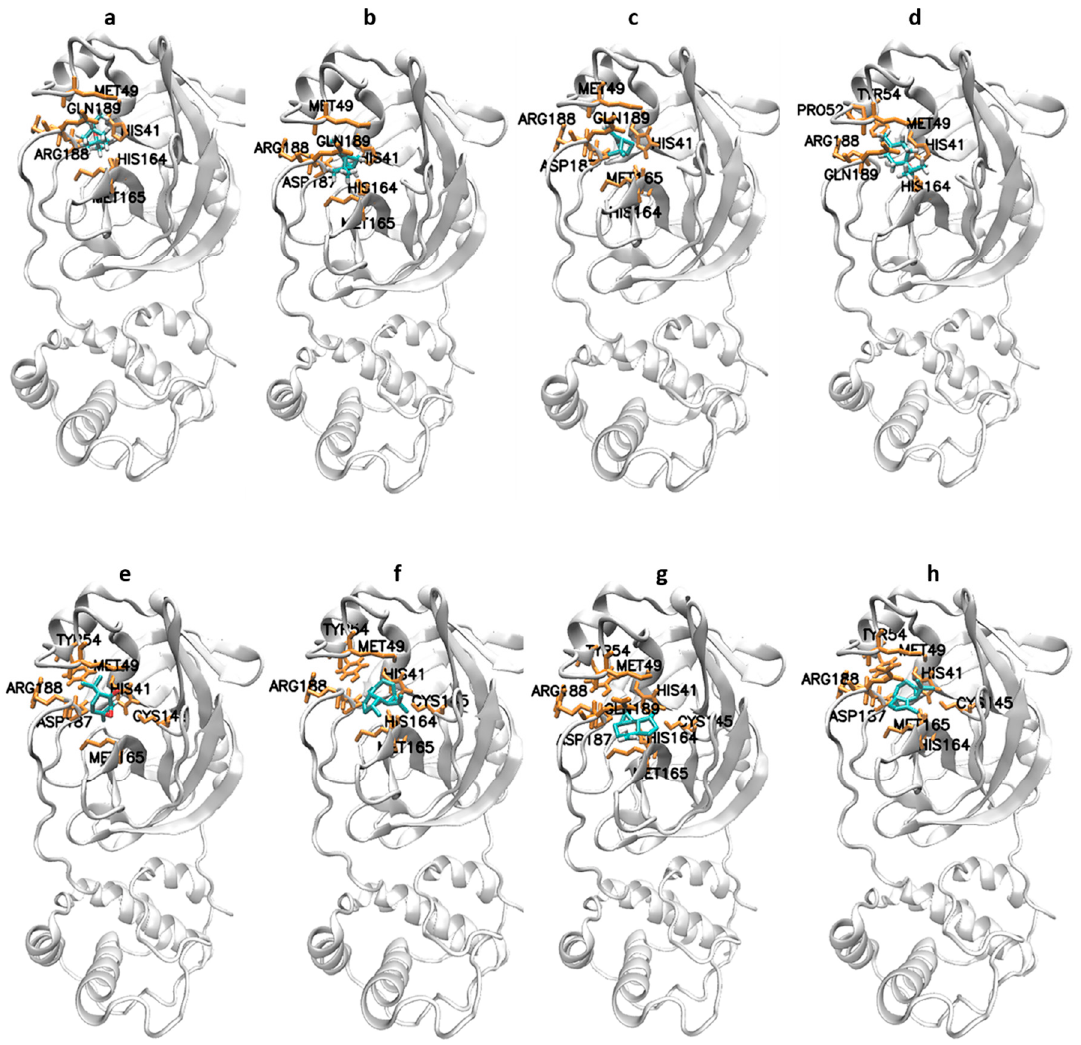
Figure 4. Predicted binding amino acid residues from the docking simulation of Mpro in complex with ( a ) 1, 8-cineole (eucalyptus), ( b ) α -pinene, ( c ) β -pinene, ( d ) terpinen-4-ol, ( e ) piperitone, ( f ) allo-aromadendrene, ( g ) aromadendrene, and ( h ) α -gurjunene.